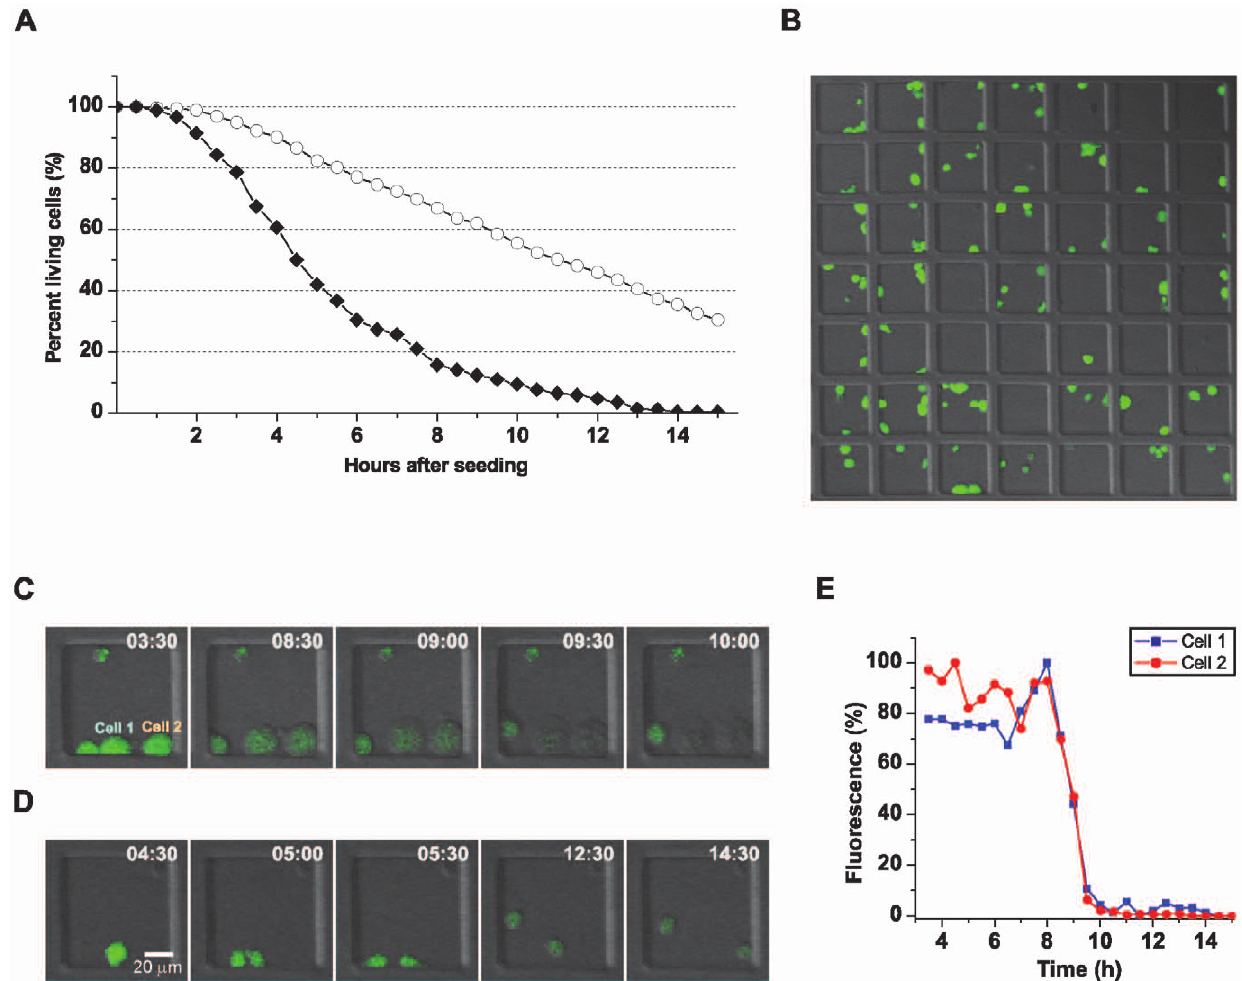
Figure 2. Cell survival in PDMS wells. Calcein-AM-labeled 221 cells were seeded, confined in PDMS wells and imaged at 37 u C, 5% CO 2 . Images were acquired of 81 wells every 30 minutes for 15 hours. (A) Cell survival comparing two different techniques to make the wells hydrophilic; fibronectin coating (– # –) and oxygen plasma treatment (– u –). The graph shows the weighted values for 5 (plasma treatment) and 7 (fibronectin coating) survival studies. (B) Micrograph of a small part of a fibronectin coated chip that was imaged over time, here showing a snapshot at t=2 h. (C, D) Time-lapse of two individual wells, showing cell death observed by calcein leakage (C), and a cell dividing during the experiment (D). (E) The calcein intensity of cell 1 and 2 shown in (C) are plotted as percentage fluorescence showing the intensity drop due to leakage of the dye, indicating cell death. Intensity values are compensated for bleaching by normalizing with the intensity of four other cells in the same image that were neither dividing nor dying during the imaging